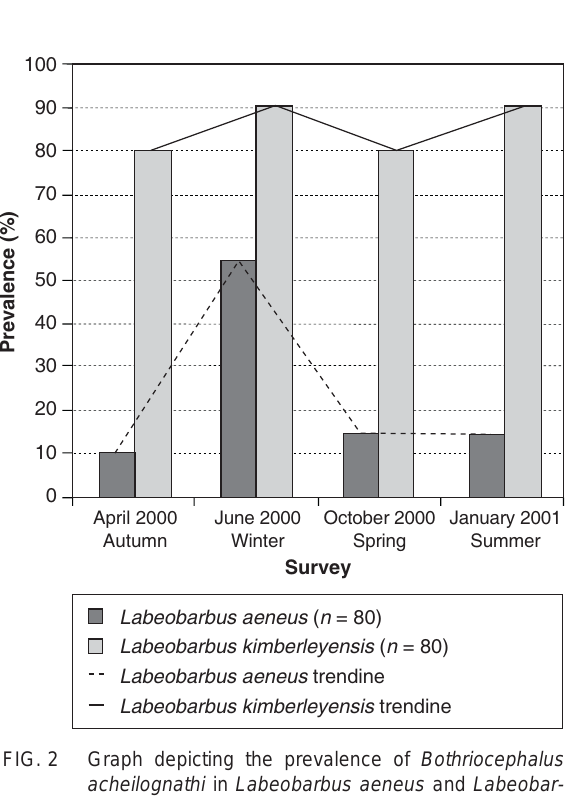
FIG. 3 Graph depicting the abundance (relative density) of Bothriocephalus acheilognathi in Labeobarbus aeneus and Labeobarbus kimberleyensis during the four sea- sons of the